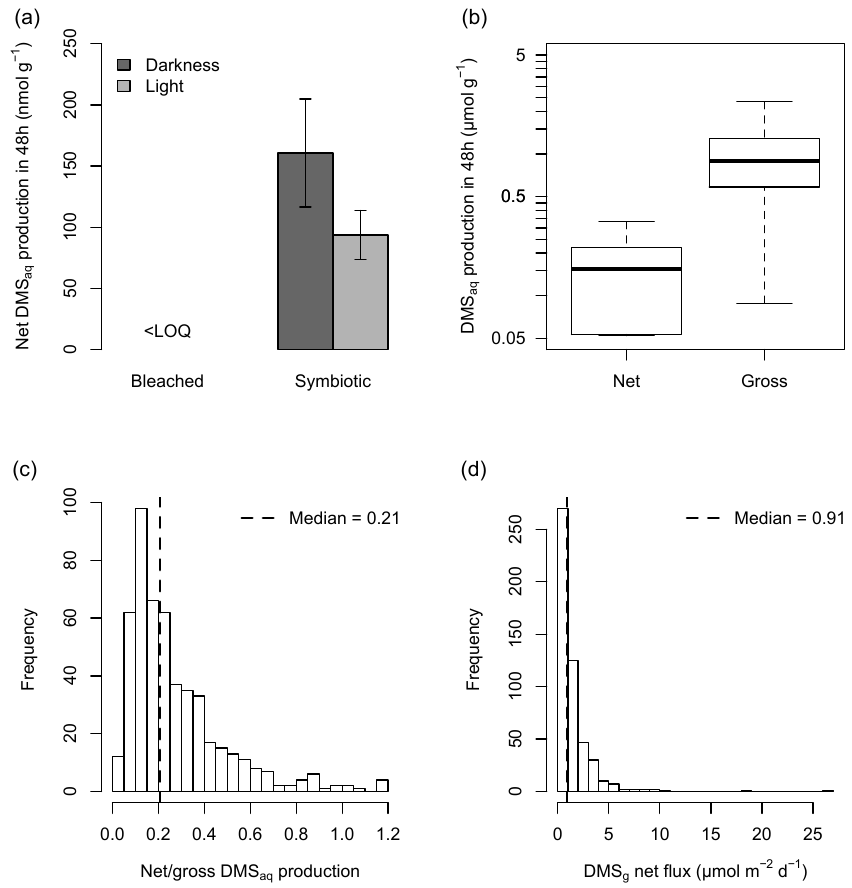
Figure 2. (a) Biomass-normalised (dry weight) net DMS production (mean ± SE) for symbiotic and bleached anemones during light and dark treatments ( n = 6). (b) Box plot showing the difference ( P< 0 . 001) between the biomass-normalised (dry weight) observed net DMS aq production ( n = 6) and the simulated gross DMS aq production after 500 simulations for symbiotic anemones. Boxes show first and third quartile ranges, thick lines indicate median values, and error bars show the range of data. Please note the logarithmic scale along the y axis. (c) Distribution of the net / gross production ratio after 500 simulations. (d) Distribution for coral-driven daily net DMS g flux into the atmosphere normalised by coral surface area after 500 simulations. LOQ, limit of quantification; DMS aq , aqueous dimethyl sulfide; DMS g , gaseous dimethyl